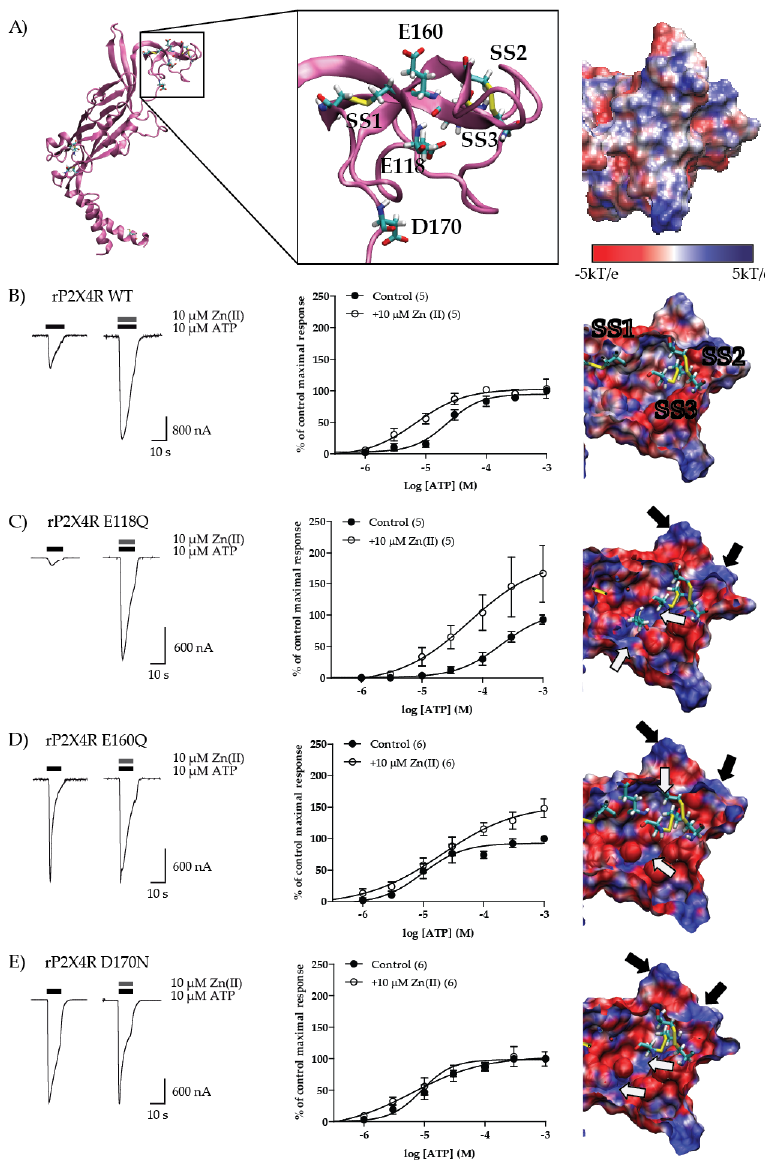
Figure 6. Electrophysiological recordings and electrostatic potential of the rP2 × 4R and E118Q, E160Q, and D170N mutants. ( A ) Representation of a rP2 × 4R monomer with SS1–5 (left) and enclosure of the head domain showing SS1-3 and acid residues (midle), with the external surface electrostatic potential (right). ( B – E ) Left panel, representative traces of the 10 µ M ATP evoked currents in the absence and in the presence of 10 µ M Zn(II), the middle panel shows the ATP concentration–response curves in absence (black) and presence (white) of 10 µ M Zn(II); the right panel shows the electrostatic potential in head domain of each receptor mutant (please note the SS1, SS2 and SS3 as reference) for the WT receptor and E118Q, E160Q, and D170N P2 × 4R mutants, respectively. The arrows in the right column show the most obvious changes on the electrostatic potential, black arrows for the surface, and white arrows for protein residues inside the model. Symbols on the graphs represent mean values, bars S.E.M. In parenthesis, is a number of replicas of each ATP curve. Note that D170 is not shown in the E right panel because it is located in the linker region immediately beneath the head domain (see the magnification in ( A )). All electrostatic calculations were made in the full trimeric P2 × 4R and mutants; we show the head domain of a monomer as a simplified model.